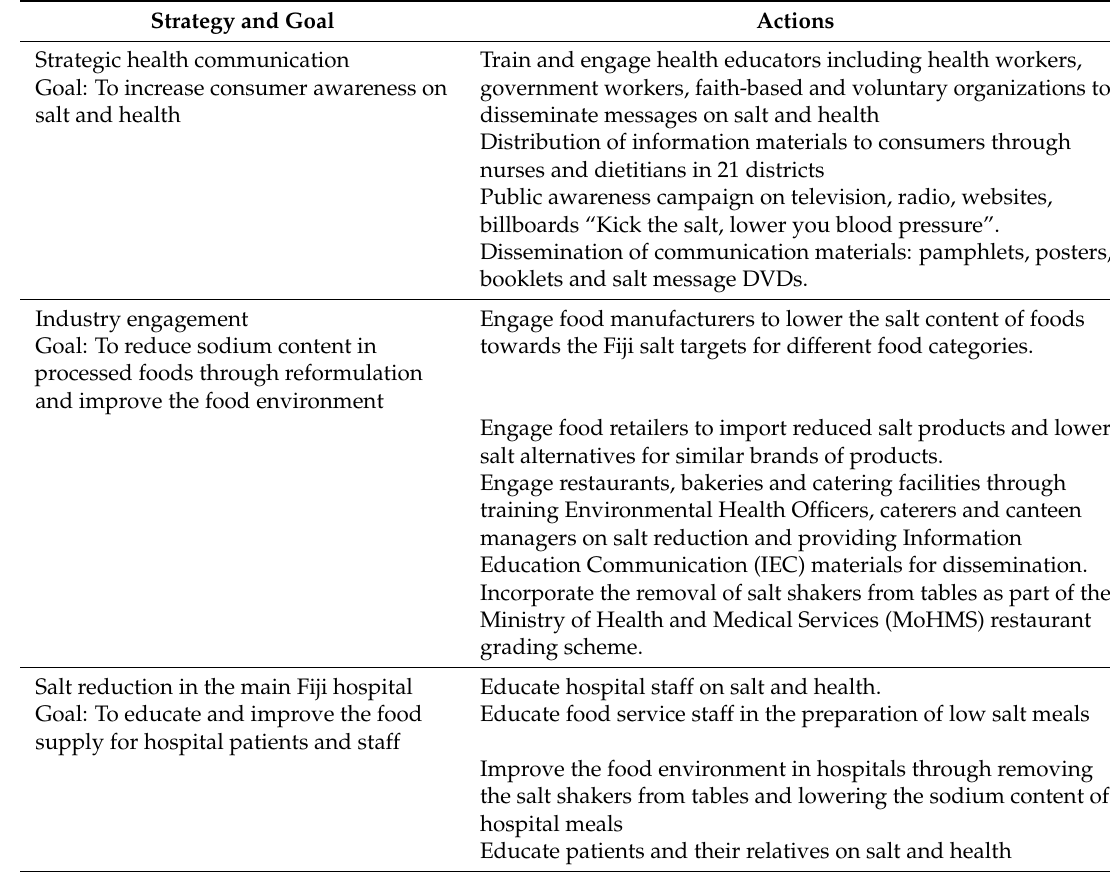
Table 1. Intervention